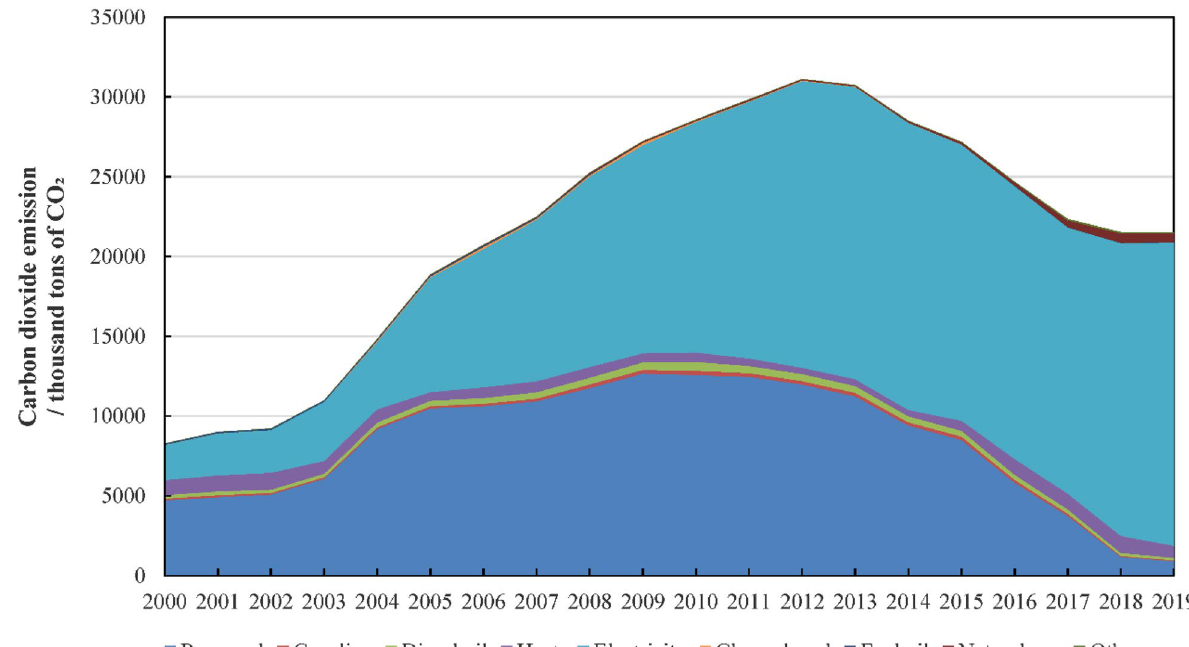
Fig. 4 CO 2 emissions of the wood and bamboo processing industry in China from 2000 to 2019